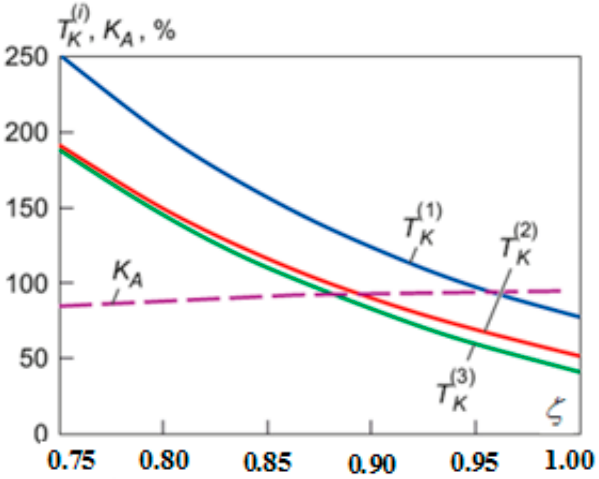
Figure 14. Dependence of the readiness coefficient and the TIBV on the total production capacity of